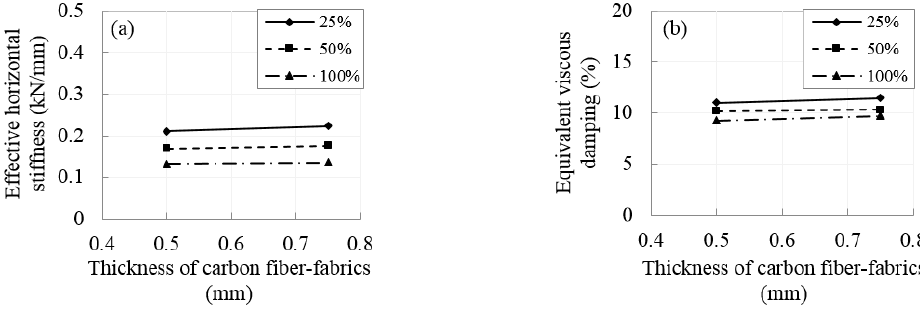
Figure 14. Effect of thickness of fiber-reinforced layers on ( a ) effective horizontal stiffness and ( b ) equivalent viscous damping of C-FREIs at 25%, 50%, and 100% shear strains.